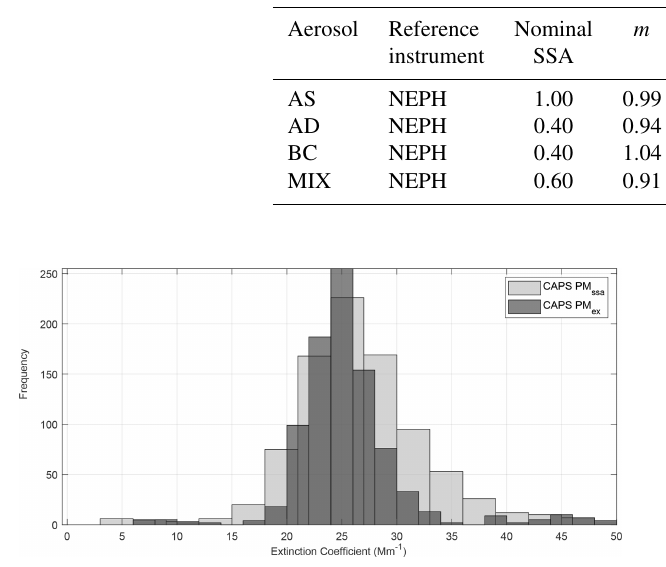
Figure 6. Scatterplot and regression line and equation of σ ep measured by the CAPS PM SSA and by proven technologies for all tested aerosols for the 10s average data. Table 8. Linear-regression parameters obtained by fitting 10s averaged data including the slope ( M ), standard deviation of the slope (SD m ), intercept ( B ), standard deviation of intercept (SD b ) and linear-regression coefficient ( R 2 ) for the comparison of the CAPS PM SSA scattering channel with NEPH.